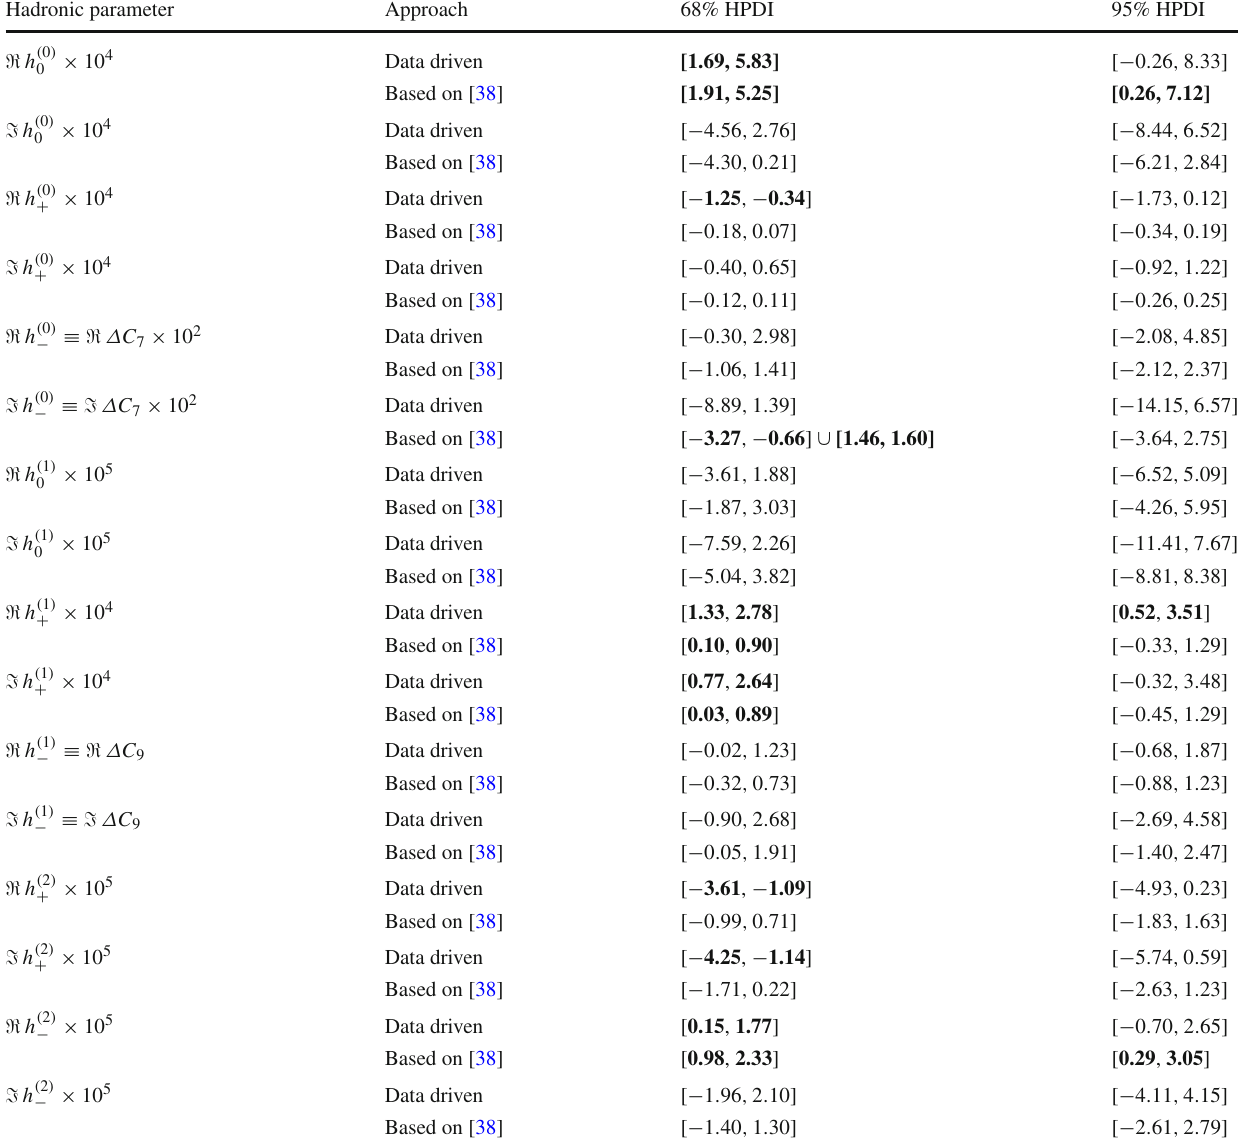
vanishing at the 2 σ level in the model-dependent approach based on ( 1 ) Ref. [38], while h + deviates from zero at more than 2